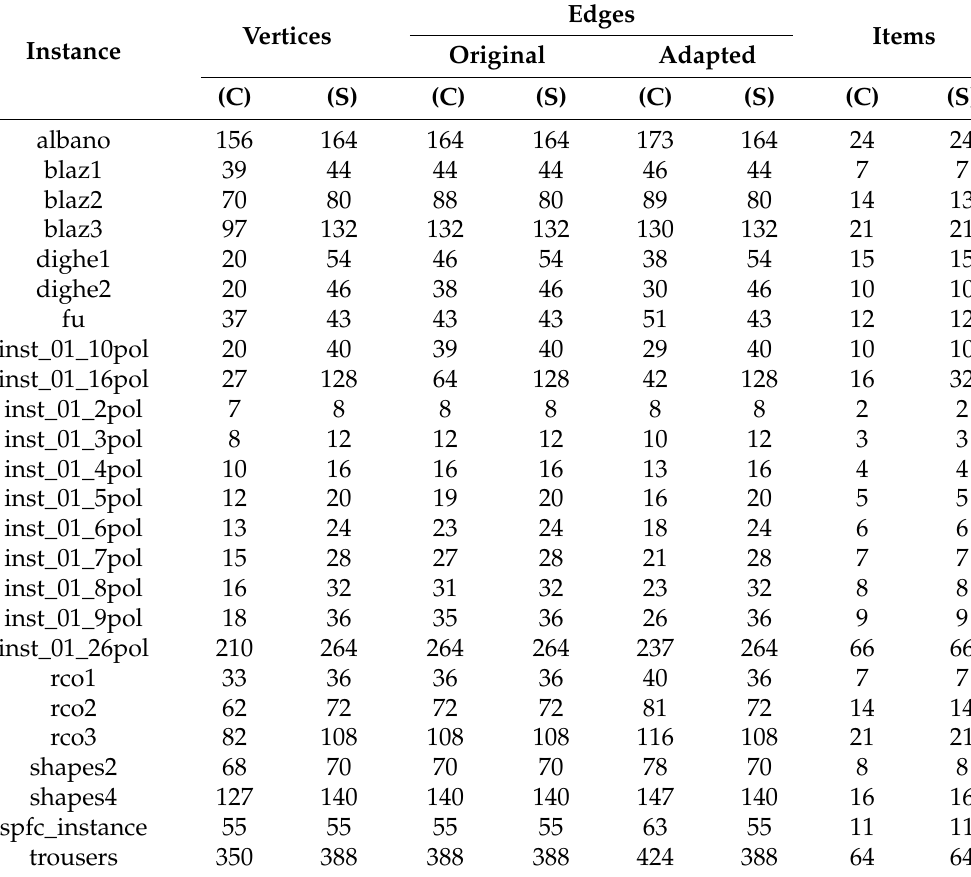
Table 1. Characteristics of instances used in the computational